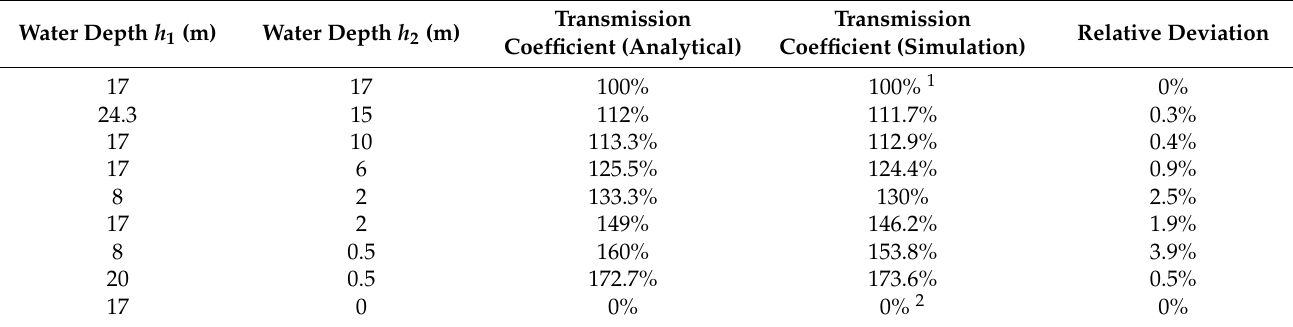
Table 3. Comparing the results of the analytical solution and the simulation results, a maximum relative deviation of around 4% can be seen. In general, it can be stated that the hydrodynamic numerical simulations match the analytical solutions for a wide variety of different bottom steps. Table 3. Comparison of calculated and simulated transmission coefficients for different depths.